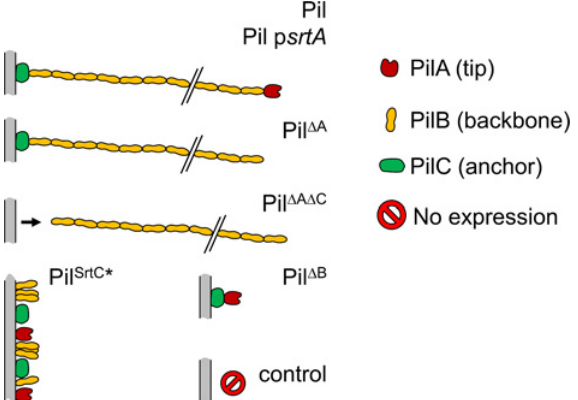
Fig 1. Predicted pilus topology of the strains used in this study. Scheme not to